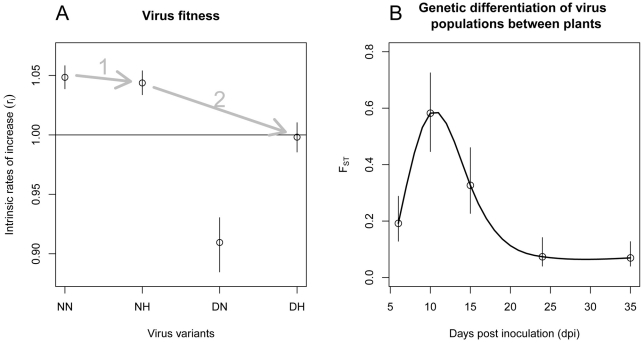
Parameter estimates of the model that is best supported by the data (model

).
A: Relative fitness of the four PVY variants (NN, NH, DN and DH) estimated by their intrinsic rates of increase r. The mean fitness of the population was arbitrarily set to 1 due to identifiability constraints (Text S1). In both graphs, dots indicate the mean values of the parameter whereas segments stand for the 95% confidence interval. Arrows indicate the most likely pathway leading to the resistance-breaking variant. B: F
ST indices as a function of time (dpi). F
ST characterizes the degree of genetic differentiation of the virus populations between plants. For each sampling date ,  was assessed as  where  is the scale parameter of a Dirichlet-multinomial distribution. For illustration purposes, a spline function (full line) is fitted to data.